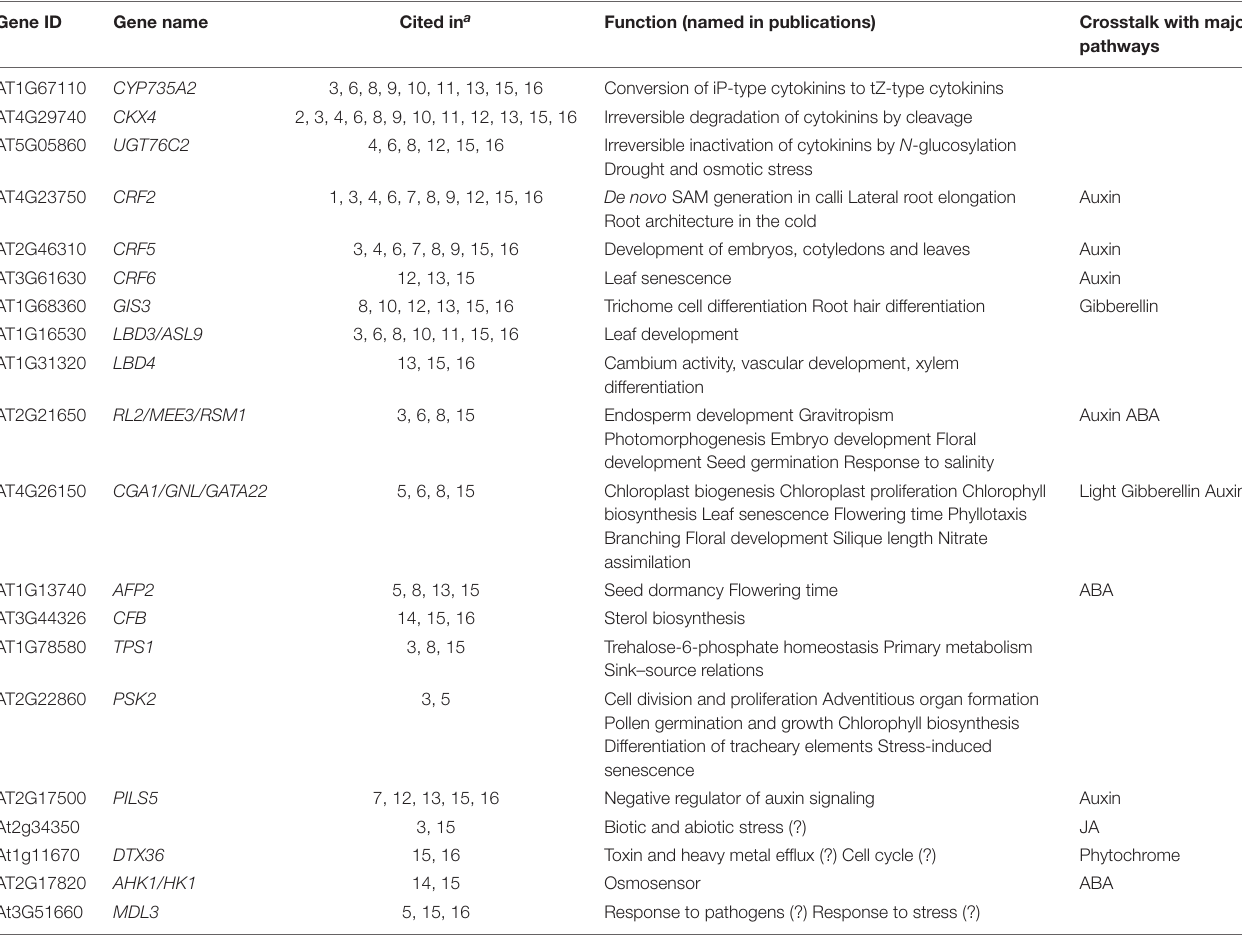
TABLE 1 | Cytokinin-regulated genes reviewed in this